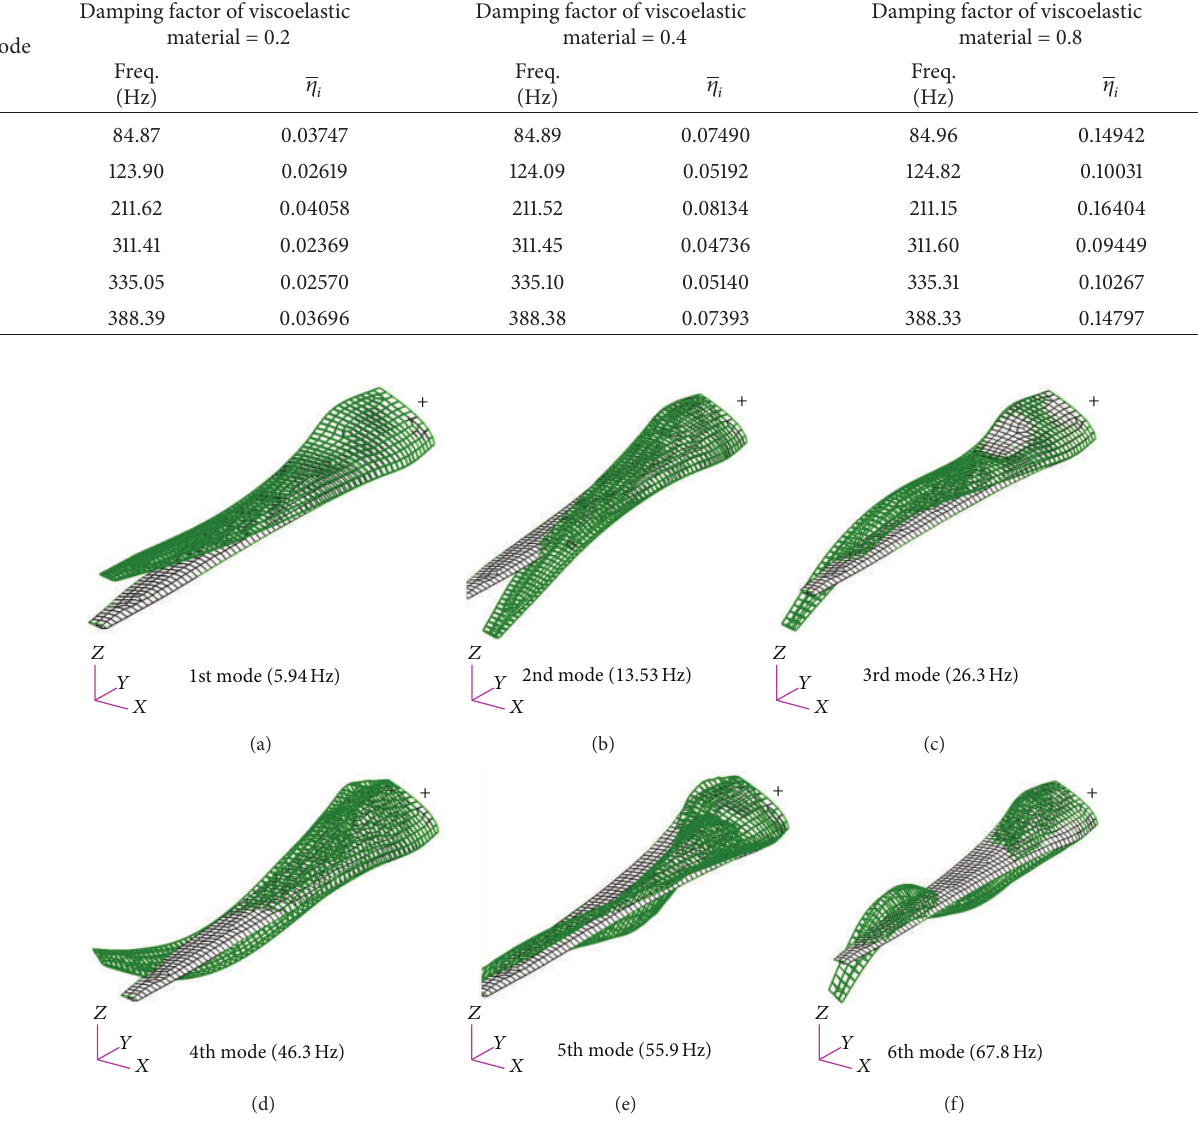
Figure 7: Mode shapes of fiber reinforced composite wind blade with damping ratio of